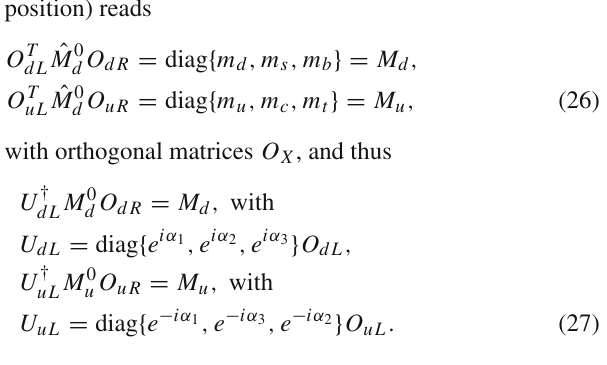
(23). In the parameter space not covered above, there is no CPV